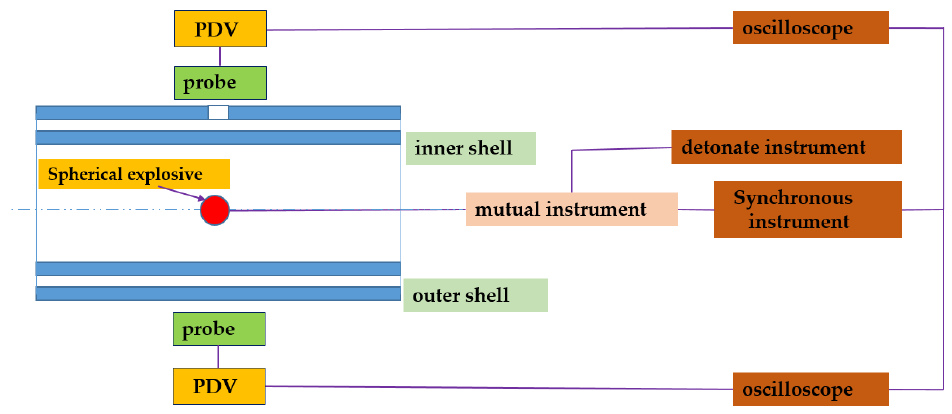
Figure 2. Schematic diagram of PDV measurement